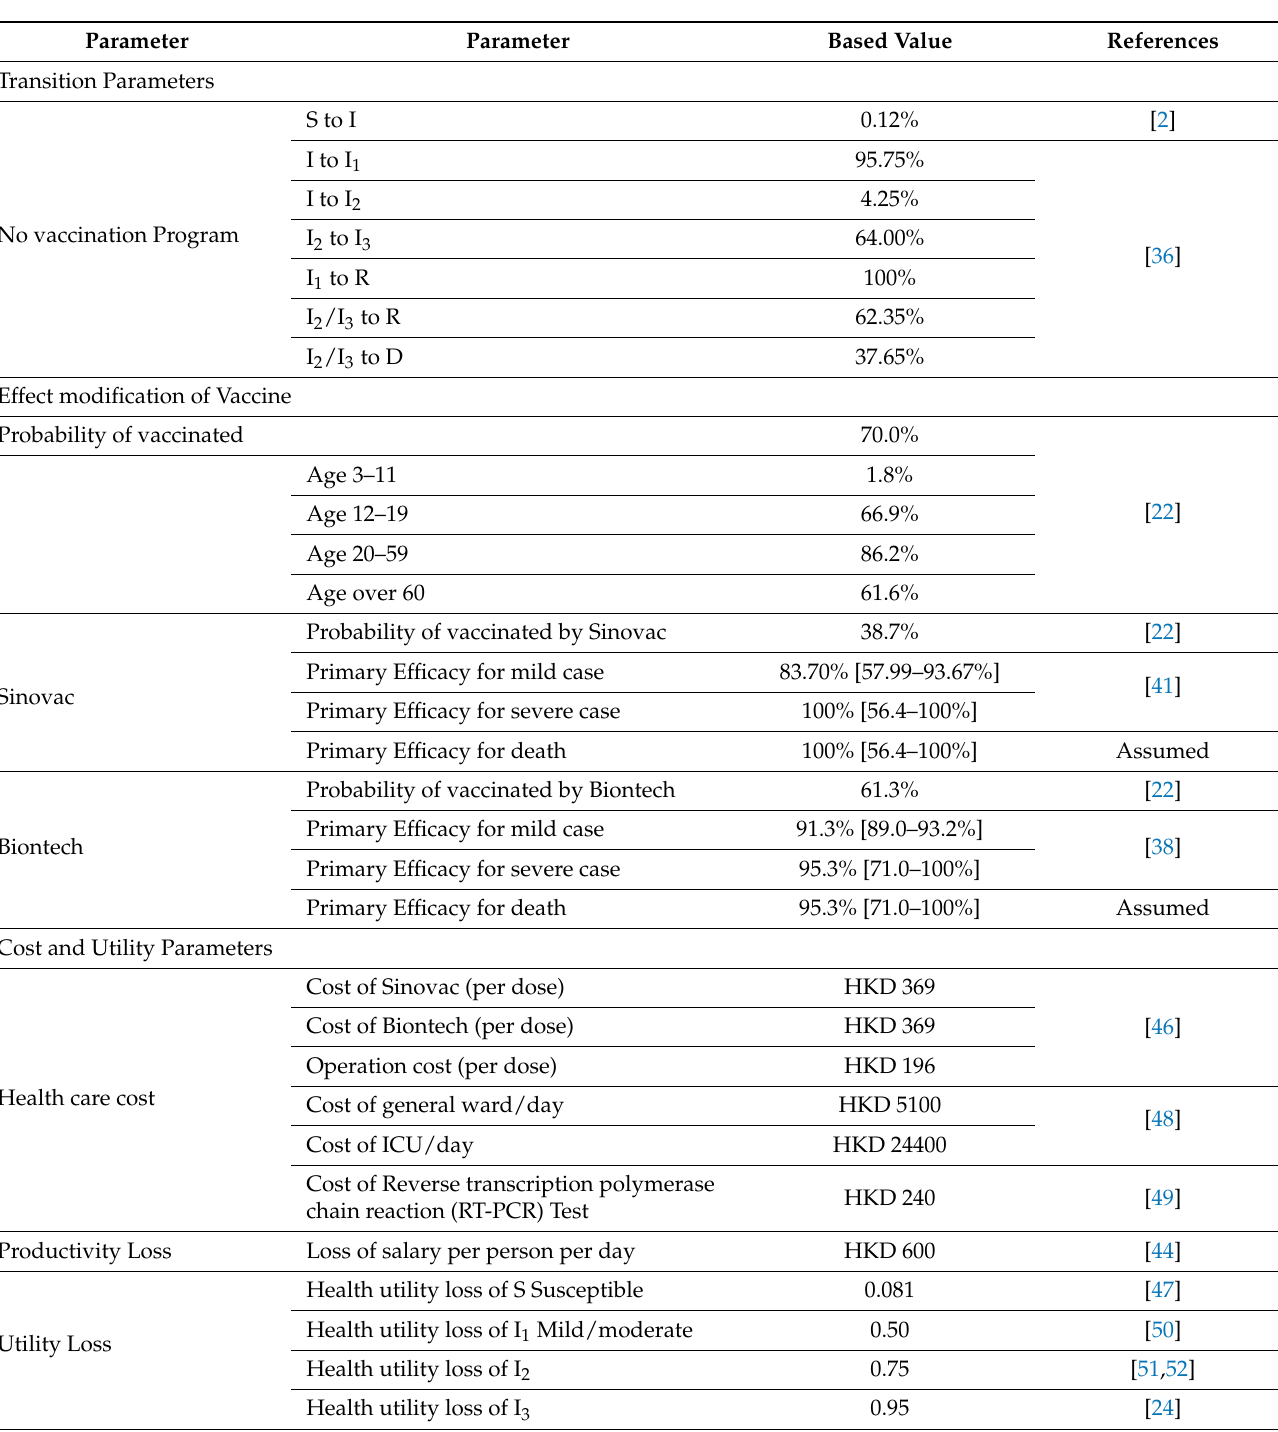
Table 1. Model main